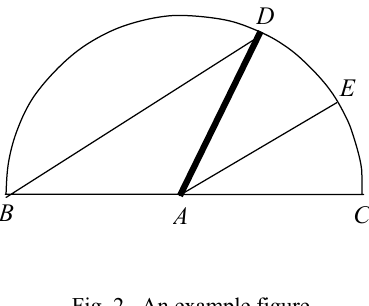
Fig. 2. An example